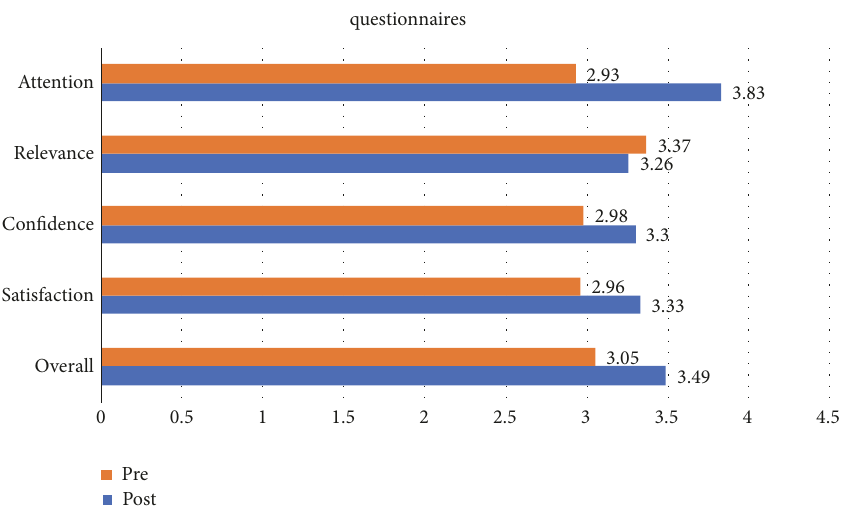
Figure 5: Comparison of mean values for the preusage and postusage